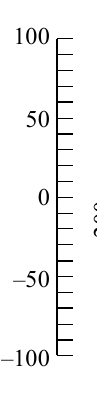
Figure 7. Designed acoustic flat lens. The size is a × ∆ d = 200 × 10 mm 2 . A 1D straight acoustic waveguide structure ( w = 0.8 mm and l = ∆ d = 10 mm) is adopted for #0. The structures of #1–#3 in Figure 2 correspond to #1–#3 in this figure and calculated waveguide lengths of Figure 6 are used for these.